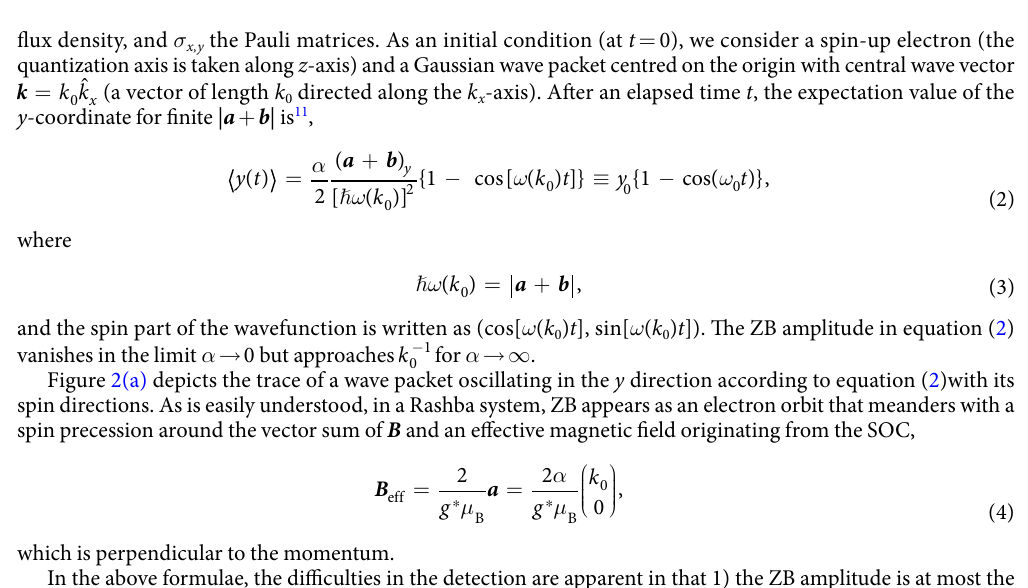
Figure 1. Pinball on a flat table. QPCs (blue) emit electrons (green balls) into a 2DEG (yellow) with impurities (red cylinders) scattering the electrons in the x - y plane. A 3D external magnetic field B is applied where azimuth φ and zenith θ are defined with respect to a z -axis set perpendicular to the x - y